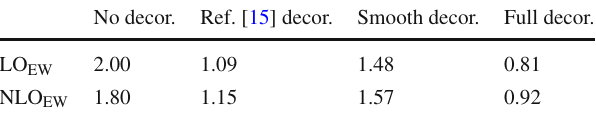
Table 3 χ 2 / N pts for the ATLAS 7 TeV inclusive jet data, as in the global MSHT20 NNLO fit ( α S free). Results including various decor- relation scenarios, explained in the text, as well including/excluding EW corrections, are shown No decor. Ref. [15] decor. Smooth decor. Full